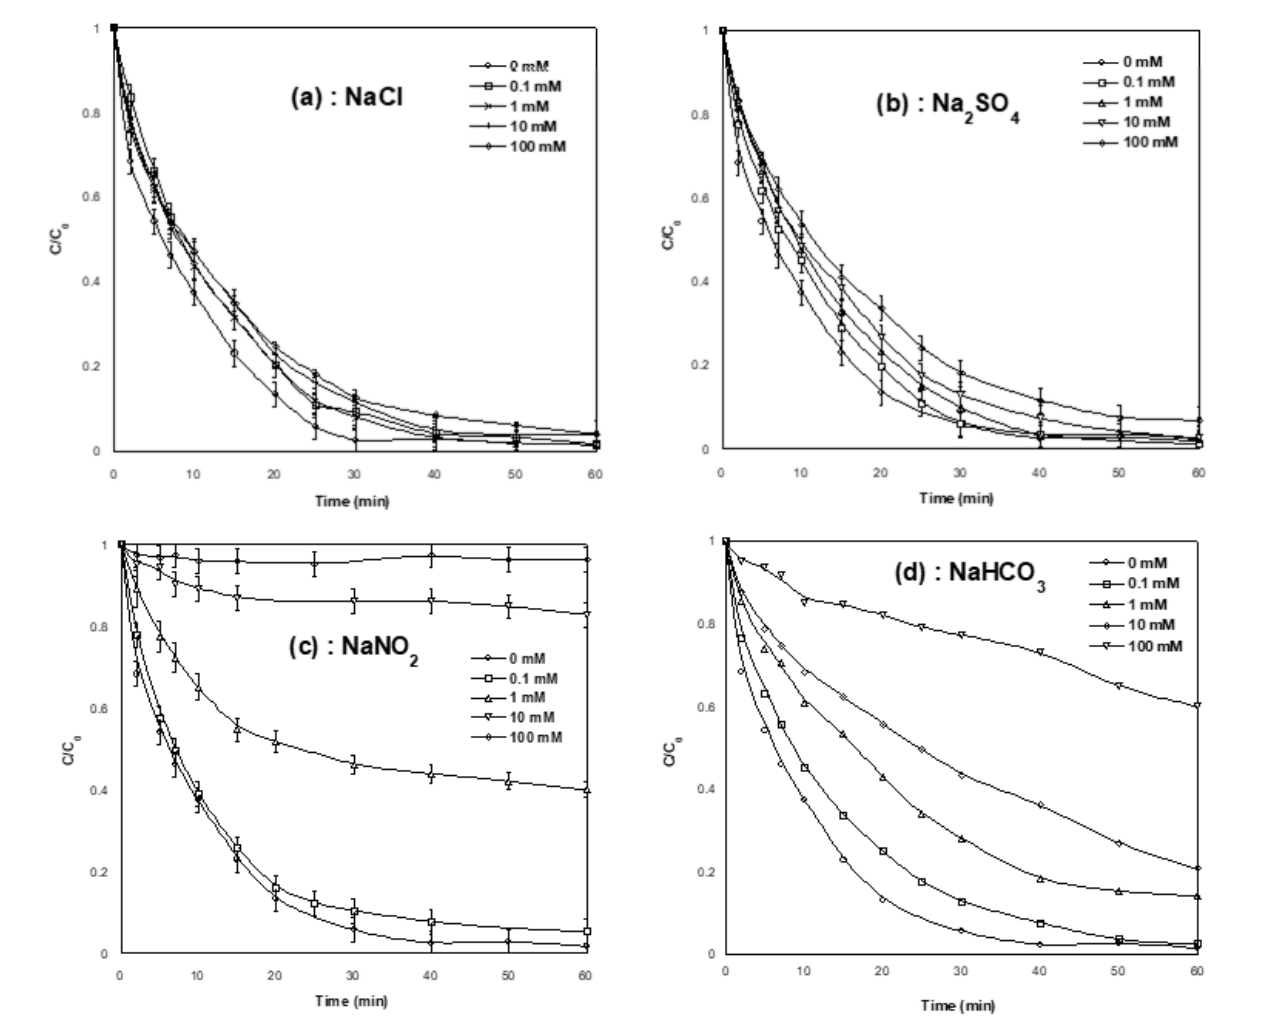
Effect of different additives on SO degradation by UV/TiO 2 /IO 3 − process: ( a ) chloride, ( b ) sulfate, ( c ) nitrite, and ( d ) bicarbonate ([IO 3 − ] = 0.15 mM, [TiO 2 ] = 0.4 g ∙ L − 1 , [SO] = 10 mg ∙ L − 1 and pH~6 (pH~8.3 for [HCO 3 − ] = 1, 10 and 100 mM)).